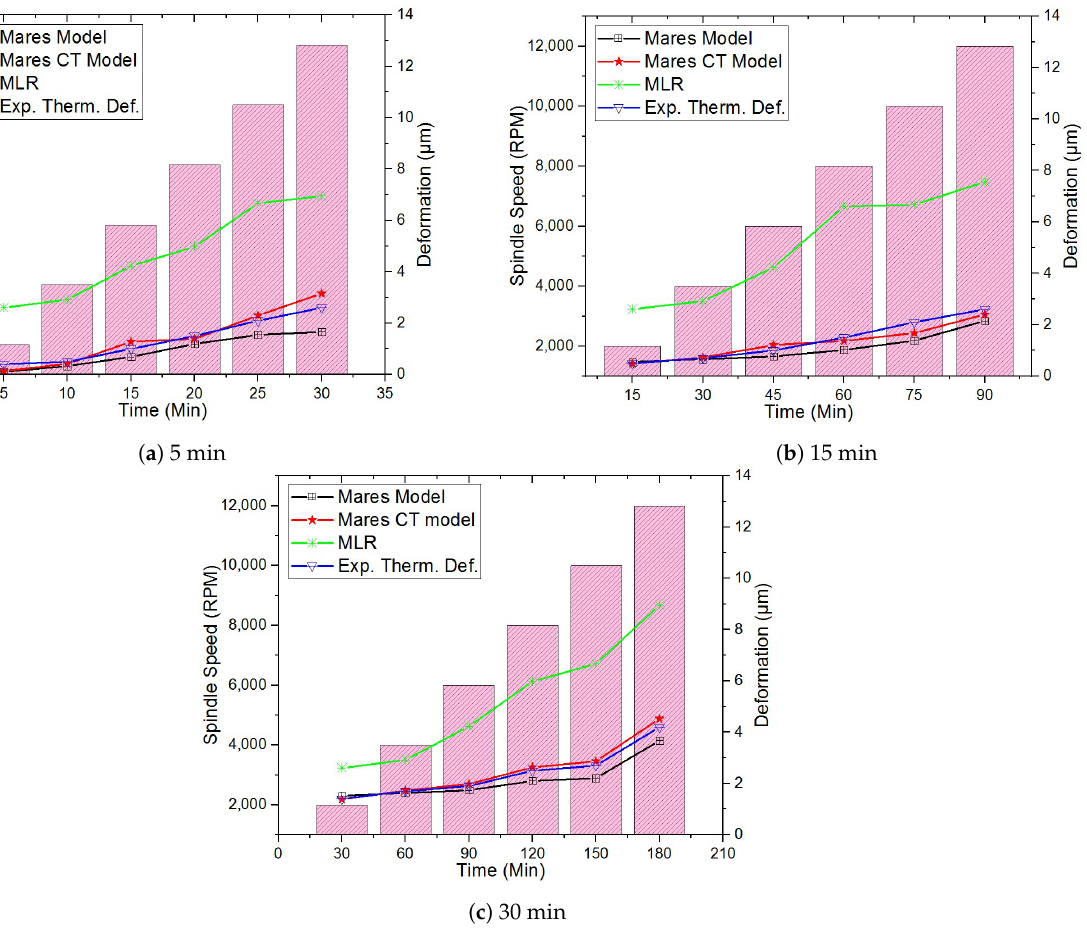
Figure 8. Thermal deformations of the CNC machine with a direct-drive spindle in the dynamic operation at the constant coolant temperature of 26 ◦ C and flow rate of 5 LPM with different spindle rotating speeds: ( a ) 5 min; ( b ) 15 min; ( c ) 30